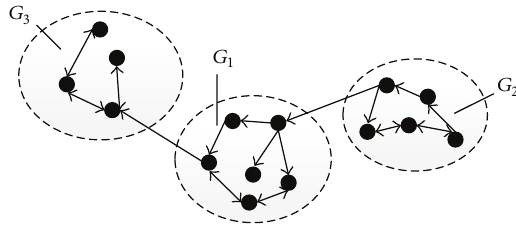
Figure 3: Model of single input and single output.